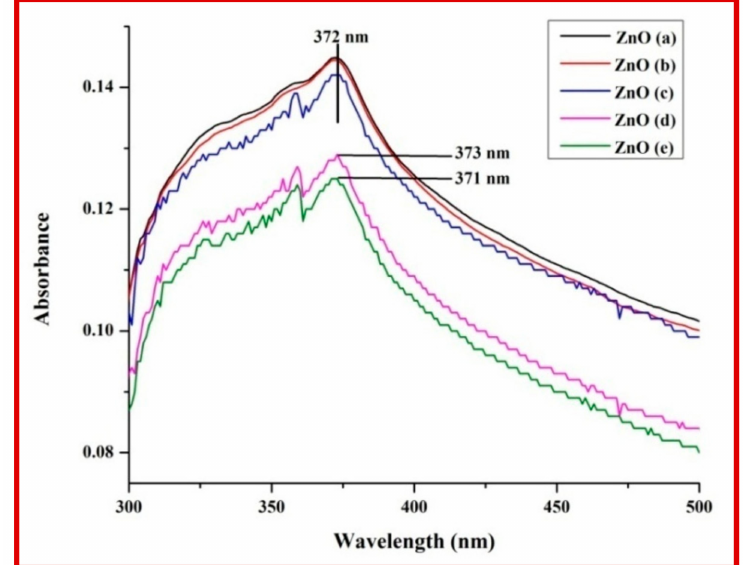
Figure 2. UV-visible spectra of various ZnO samples prepared using di ff erent concentrations of C.